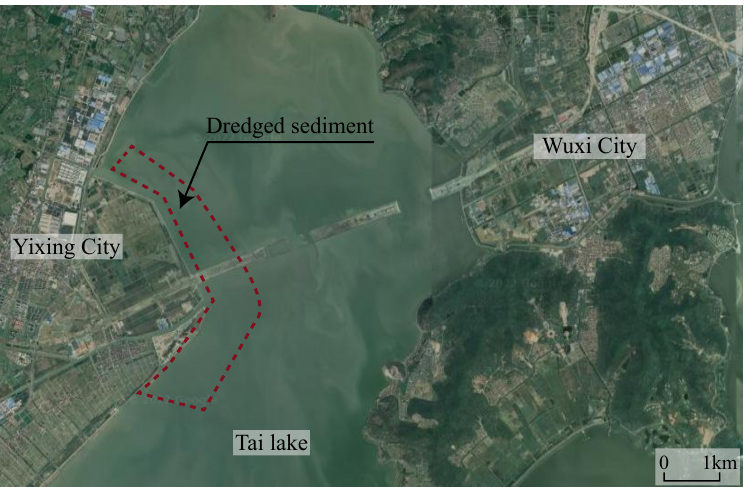
Figure 1. Location of dredged sediment from Tai Lake.